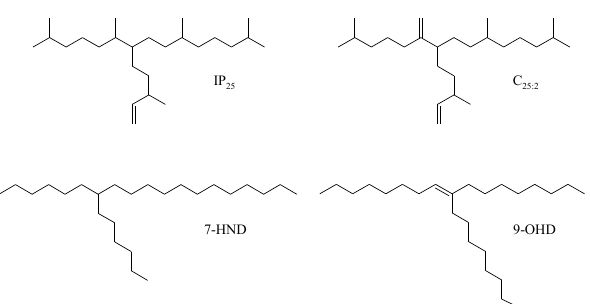
Fig. 1. Structures of IP 25 , C 25 : 2 and internal standards (7-HND and